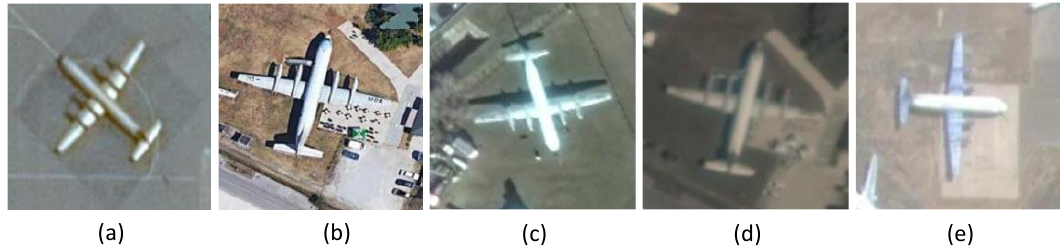
Figure 14. Examples of Type27 in the training set, it can be seen that (a) in Figures 12 and 13 is most likely